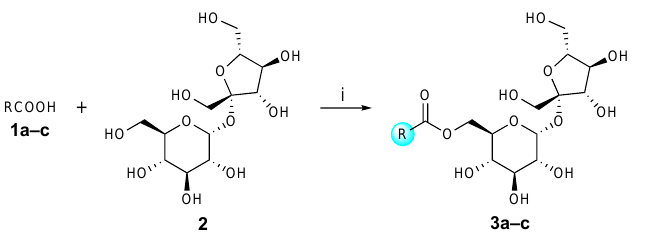
Figure 6. Chemical structures of sugar-based aromatic ester surfactants. 3.2.1. General Procedure for the Synthesis of Sucrose Aryl Aromatic and Aromatic Ester Surfactants ( 3a – c , URB1480 – 1482) (Scheme 1) [23] Sucrose ( 2 , 0.50 mmol) was dissolved in dry DMF (3.95 mL) at 70 °C under stirring and a nitrogen atmosphere. The mixture was cooled at room temperature, then PPh 3 (0.354 g, 1.35 mmol), the appropriate carboxylic acid 1a – c (0.75 mmol), and dry DMF (1.05 mL) were added. After complete dissolution, the mixture was cooled to 0 °C, and DIAD was added (0.256 mL, 1.35 mmol) dropwise, stirred for 24 h at room temperature, and concen- trated. Purification of the residue by column chromatography [CH 2 Cl 2 /CH 3 C(O)CH 3 /CH 3 OH/H 2 O 78:10:10:1.5] resulted in 3a – c as solids.